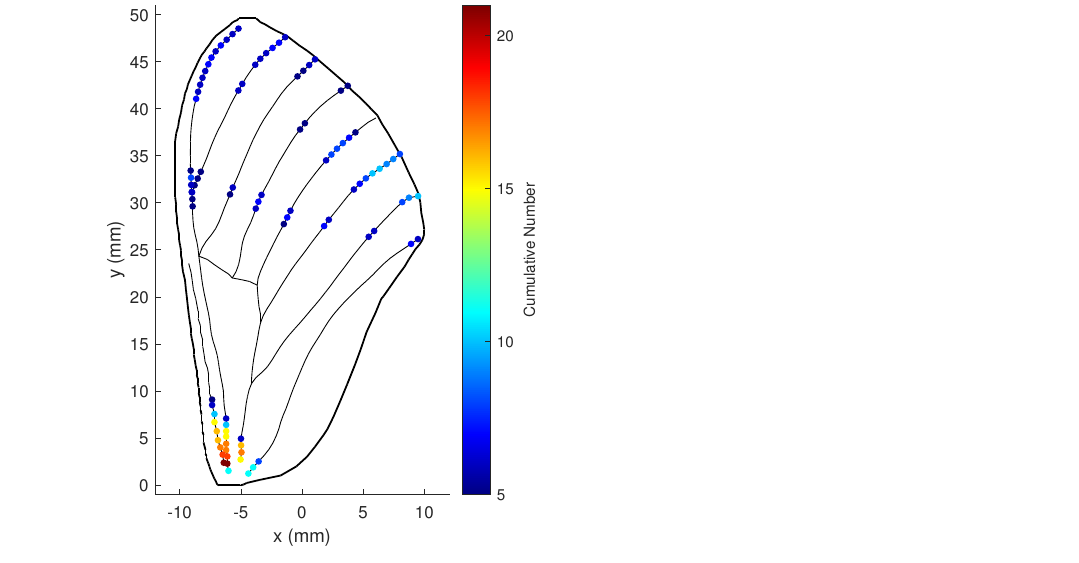
Figure 20. Cumulative numbers for being the optimal location when measurement noise variances is small: ω (cid:118) = 5, ω Υ = 100, and r = 20.